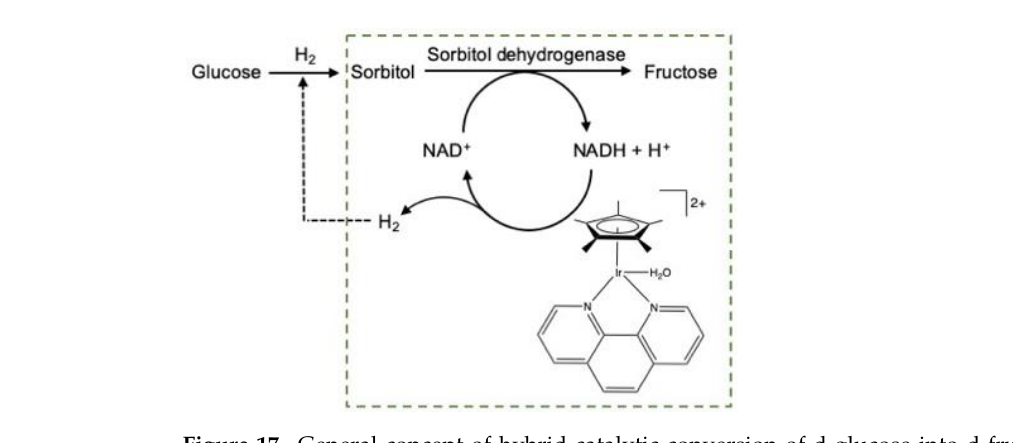
Figure 17. General concept of hybrid catalytic conversion of d-glucose into d-fructose using an iridium complex for NAD+ regeneration.